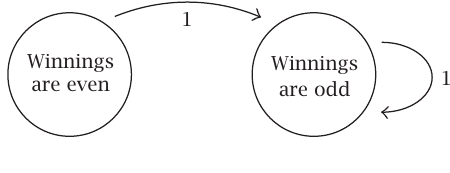
Figure 5.1 . Extreme game A